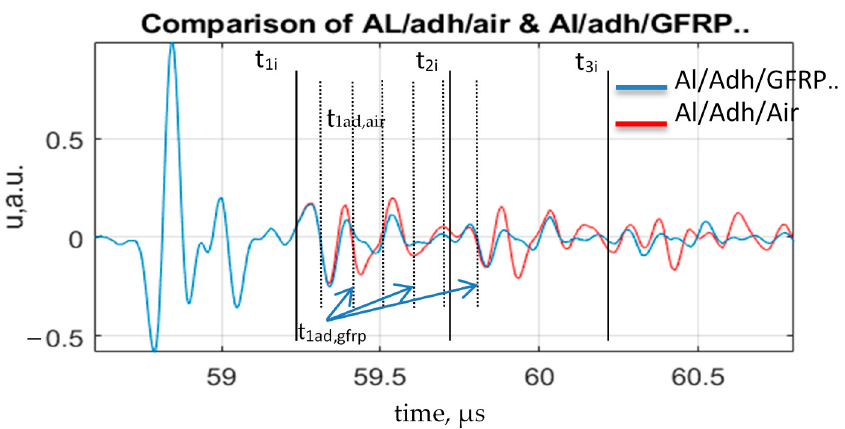
Figure 12. Comparison of two modeled signals: perfect bonding (Al/Adh/GFRP/CFRP/GFRP) and total debonding (Al/Adh/Air).